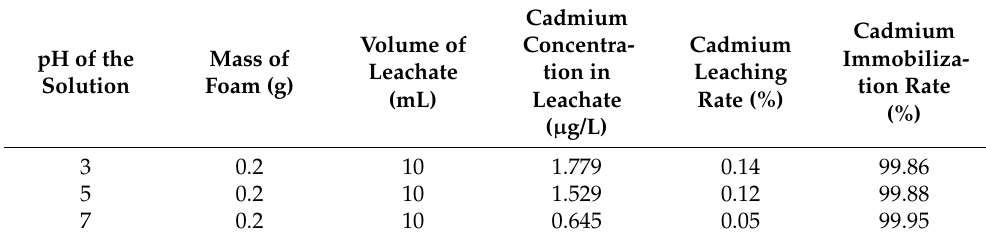
Table 4. Cadmium immobilization rate of Foam-50 soaked in different pH solutions.